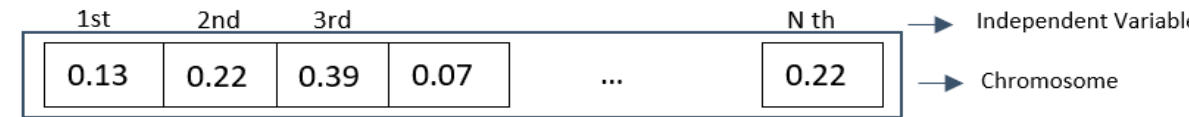
Figure 2. GA Attribute Weight Optimization Framework.